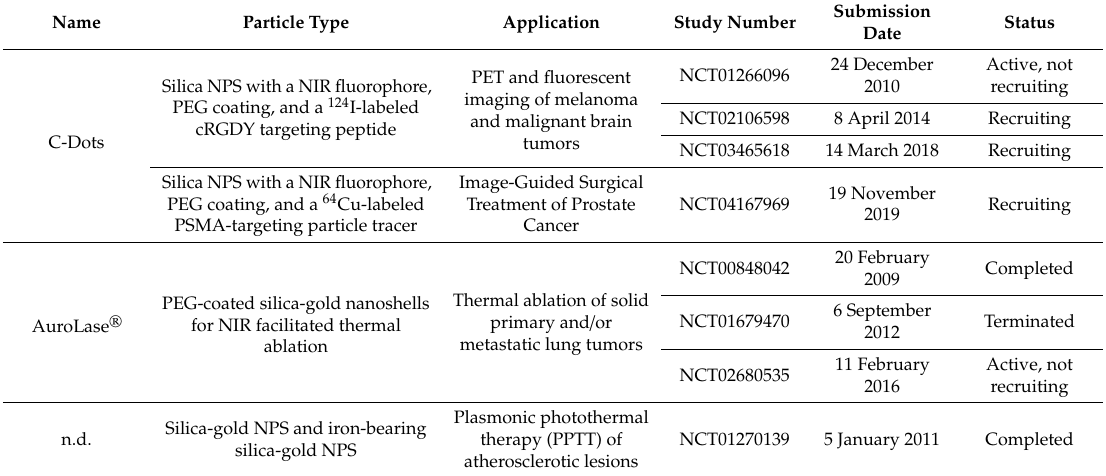
Table 1. Clinical trials on silica-based nanoparticulate